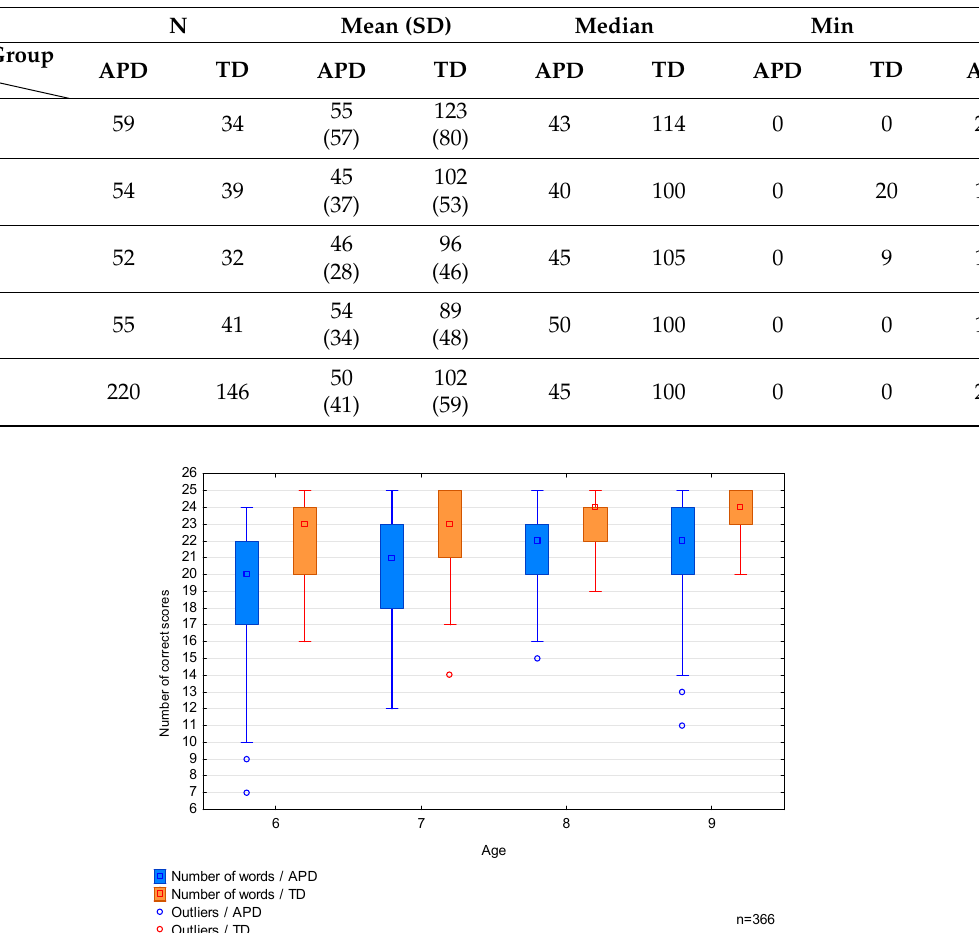
Figure 1. Comparison of the Phoneme Discrimination Test (PDT) results, among age groups, in auditory processing disorder (APD) and typically developing (TD) groups. The results of the PDT for TD participants exceeded those of APD participants. The difference was statistically significant, as confirmed by the Kruskal ‐ Wallis test for p = 0.0000. Subsequently, the Kruskal ‐ Wallis test showed that the PDT results differed between age groups within each study group, as presented in Table 6 below. Table 6. Analysis of differences between age groups for the PDT results, in APD and TD groups, with the application of the post hoc tests (multiple comparisons tests of mean ranks for all samples). Group APD TD Significance level